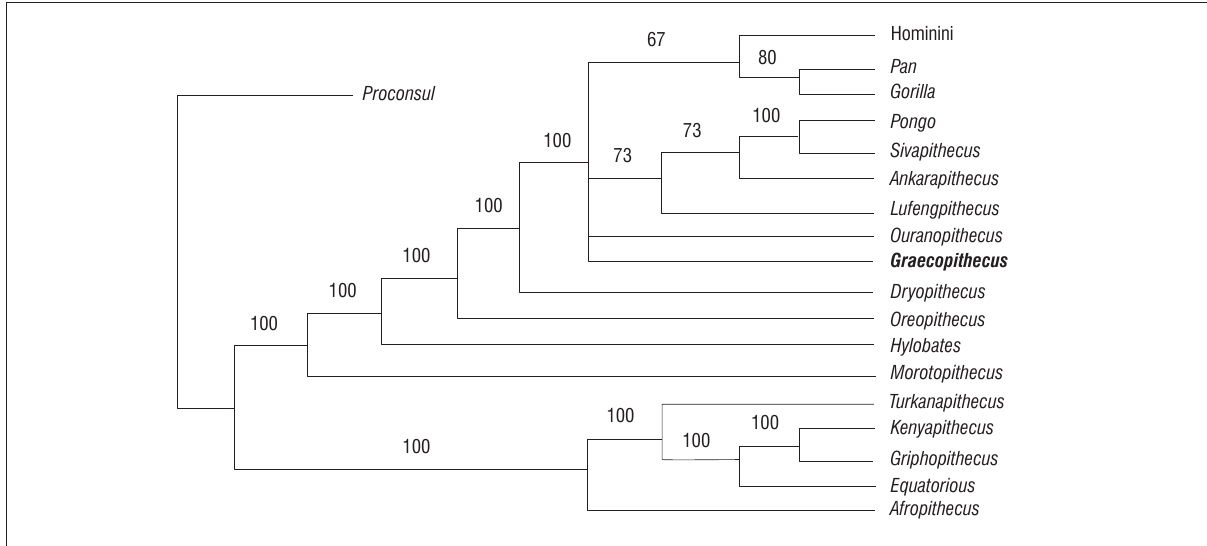
Figure 1: Majority rule consensus of the cladistic analysis performed in this study. Numbers on branches indicate the frequency (%) of the clade among the 15 most parsimonious trees. Graecopithecus appears in an unresolved position which indicates that it is either reconstructed as a Ponginae or a